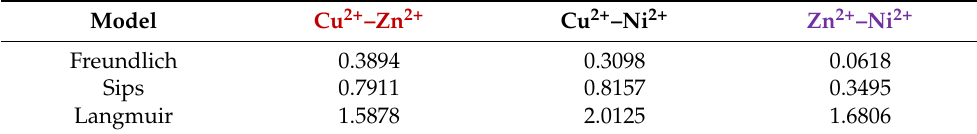
Table 2. Sum square residual (SSR) in the binary mixtures. Adapted from Reference [39].